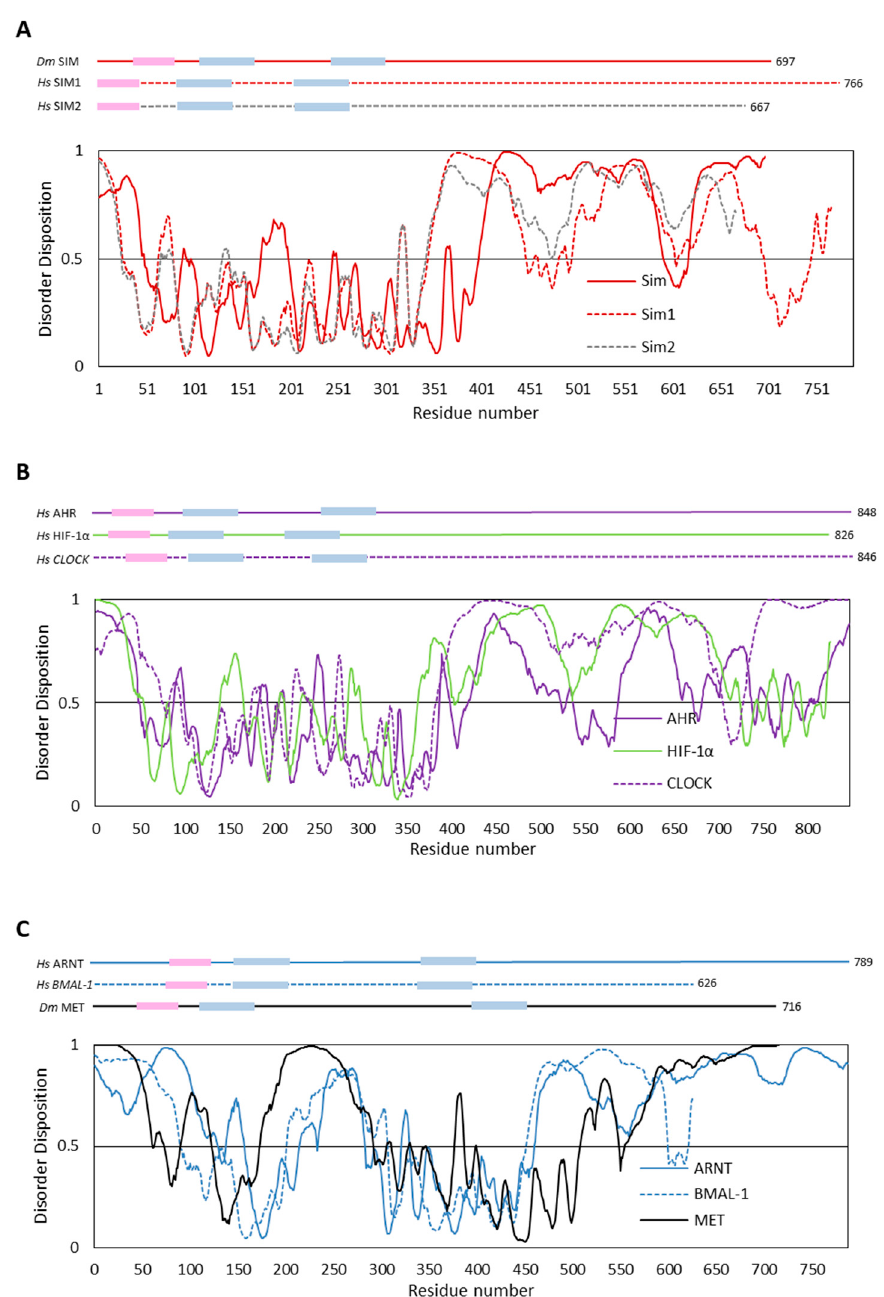
Figure 5. Prediction of intrinsically disordered regions. The top panel presents the domain structure of the analyzed bHLH–PAS proteins. Pink indicates the bHLH domain, whereas blue represents PAS domains. The length of the proteins is marked. The bottom panel presents a prediction of intrinsically disordered regions based on the amino acid sequence of proteins. All calculations were performed using PONDR-VLS2 software [57]. A score over 0.5 indicates disorder. ( A ) The class I proteins: D. melanogaster SIM (red line) and its H. sapiens orthologs SIM1 (dashed red line) and SIM2 (dashed grey line). ( B ) The class I proteins: H. sapiens AHR (violet line), HIF1- α (green line), and CLOCK (violet dashed line). ( C ) The class II proteins: H. sapiens ortholog ARNT (blue line), BMAL-1 (blue dashed line), and D. melanogaster Met (black